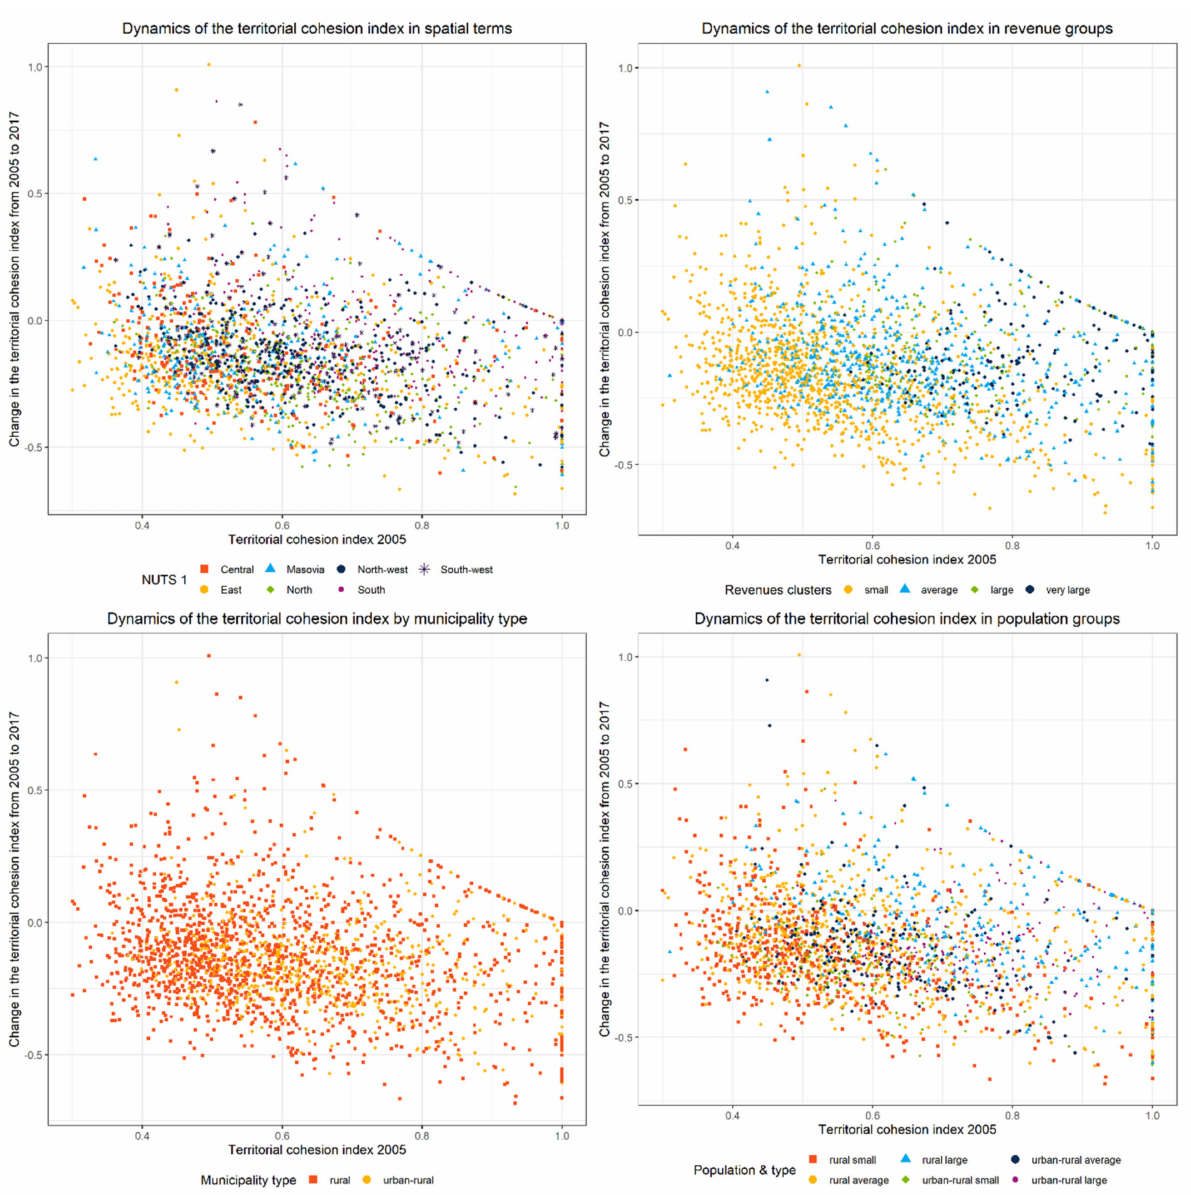
Figure 2. Dynamics of the territorial cohesion index in the studied group of municipalities in 2005–2017 in relation to the structural characteristics of the entities. Source: Own